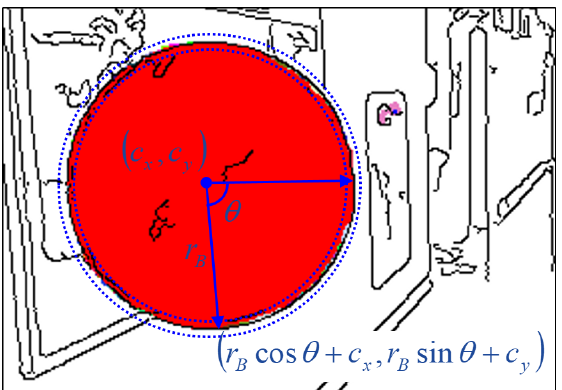
Figure 5. Multi-cue-based circle detection. Edge pixels in Figure 4a are drawn in black on the connected regions in Figure 4d. The blue dashed circles represent the search range from r − τ MC – r + τ MC for region boundary pixels. Refer to the text for more